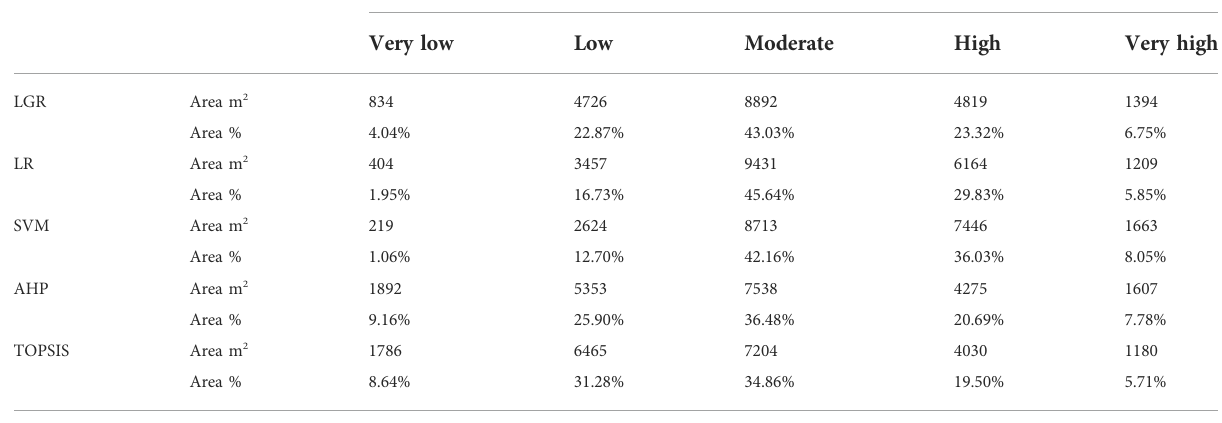
TABLE 3 Division of different landslide susceptibility classes for different methods.